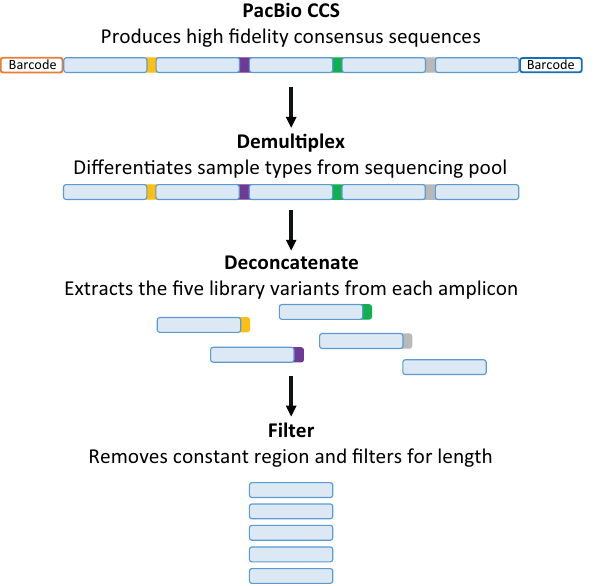
Figure 3. Overview of the post-sequencing data processing. The CCS function in the SMRT Link software v8.0 assimilated the consensus sequences from each well and removed the SMRTbell hairpin adapters. We developed a custom script to sort (demultiplex) and deconcatenate the sequences. Firstly, the sample-specific barcodes were used to separate each selection output from the mixed pool of sequences. Next, we extracted the five original library variants from the concatenated amplicon using the forward and reverse constant region at the 5’ and 3’ termini of each variant (not shown in the figure). A length filter was then applied to ensure the recovery of full-length library variants. See Supplementary Fig. S4 for further